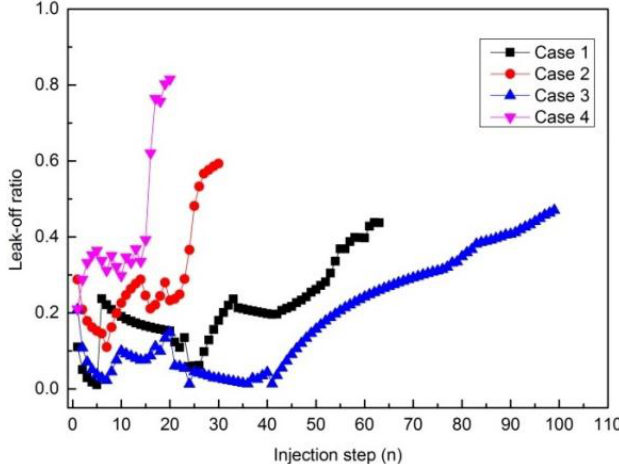
Figure 8. Comparison of leak-off ratio for different variable injection rate cases.